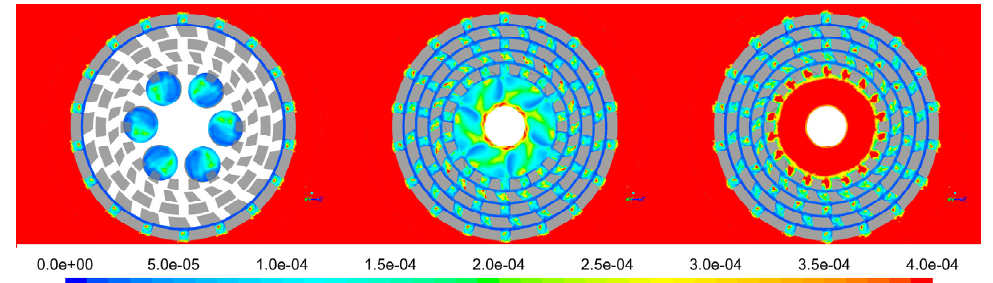
Figure 8. Parameter Ca C / G = μ C d MAX /2 σ (s) at 6000 rpm for the same planes as in Figure 4. The viscosity ratio is unity and the corresponding value of Ca C has been locally calculated from correlation (A2).